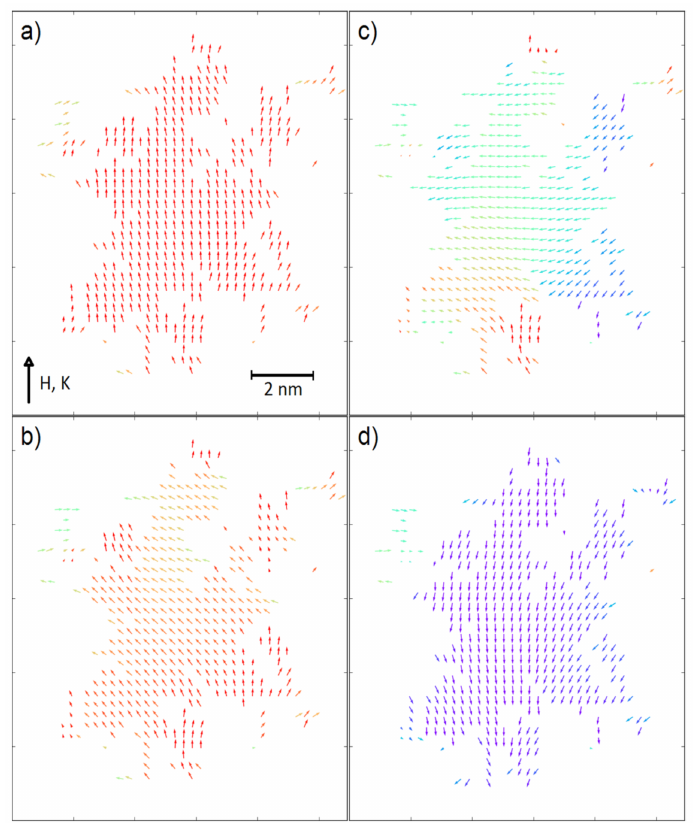
Figure 5. Spin configurations (cross-section) of the system with K S = 5 × 10 − 3 eV, K V = 0 eV, n = 1, S = 1 and N S /( N S + N V ) = 0.7 in the external magnetic field equal to ( a ) 6.2 T, ( b ) 0 T, ( c ) − 1.6 T and ( d ) − 3.6 T.